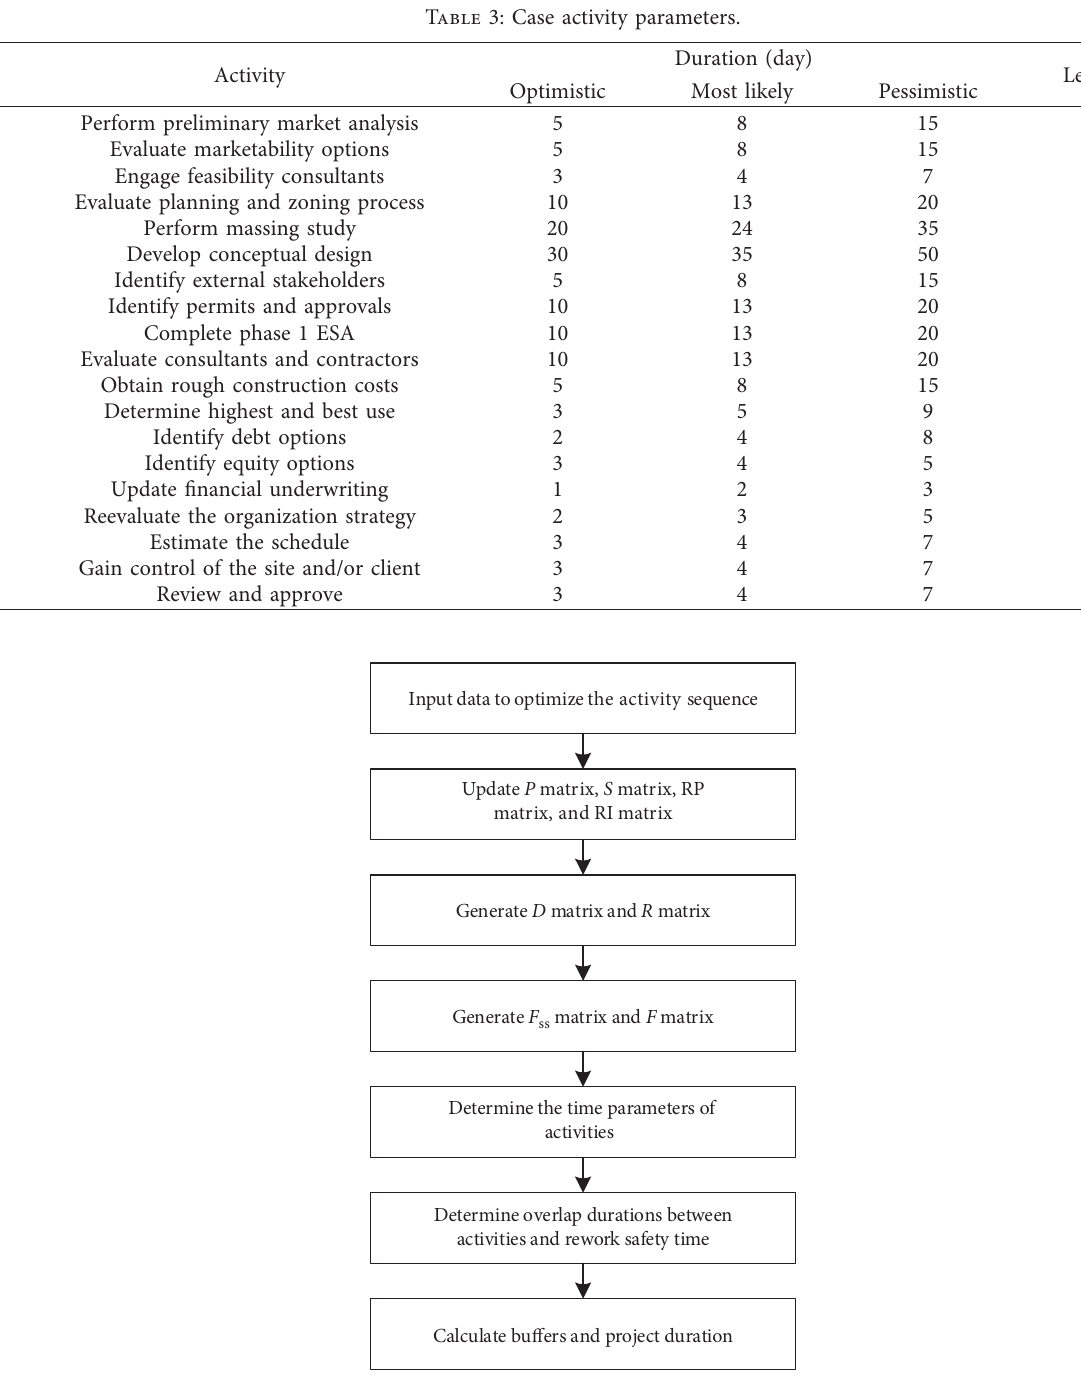
Figure 9: Flowchart of the simulation